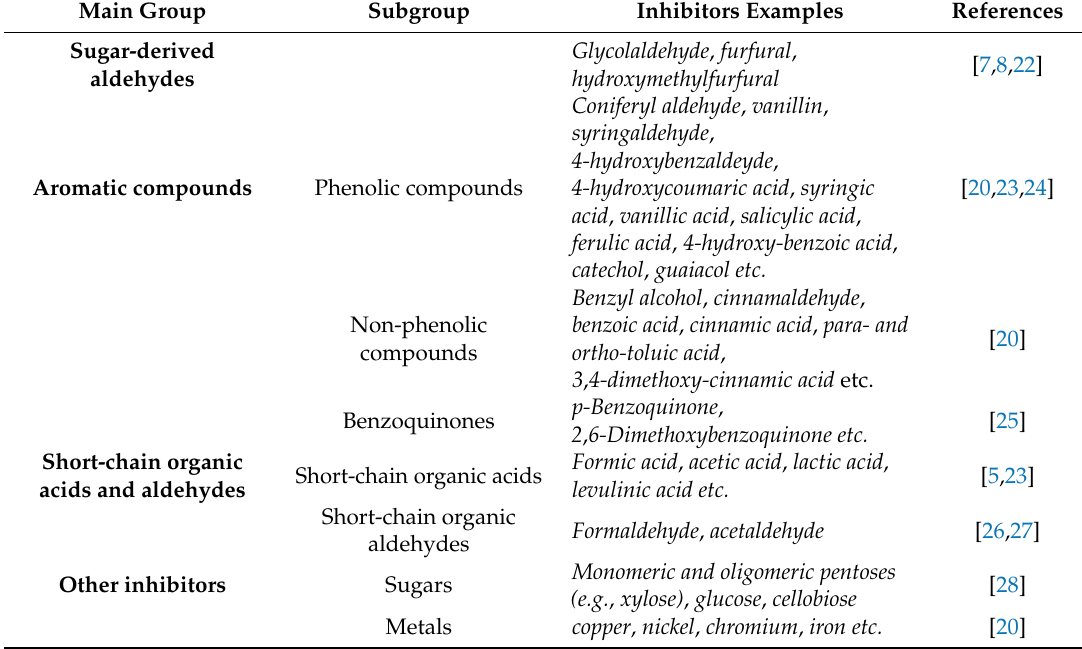
Table 1. Classification of lignocellulose